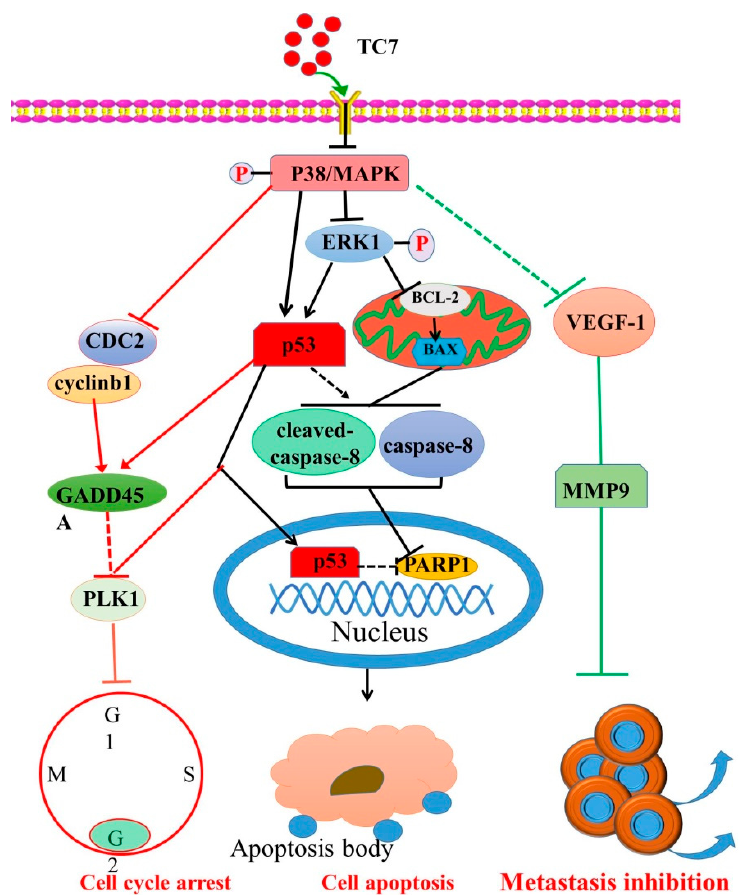
Figure 6. The proposed cell signaling pathways used by TC7 to induce PCa cell apoptosis, cell cycle arrest, and metastasis inhibition through the regulation of p38 / cyclin b1 / CDC2, and p53-dependent GADD45A / PLK1, p38 / P53 / caspase 8, and p38 / VEGF-1 / MMP-9 signaling pathway.